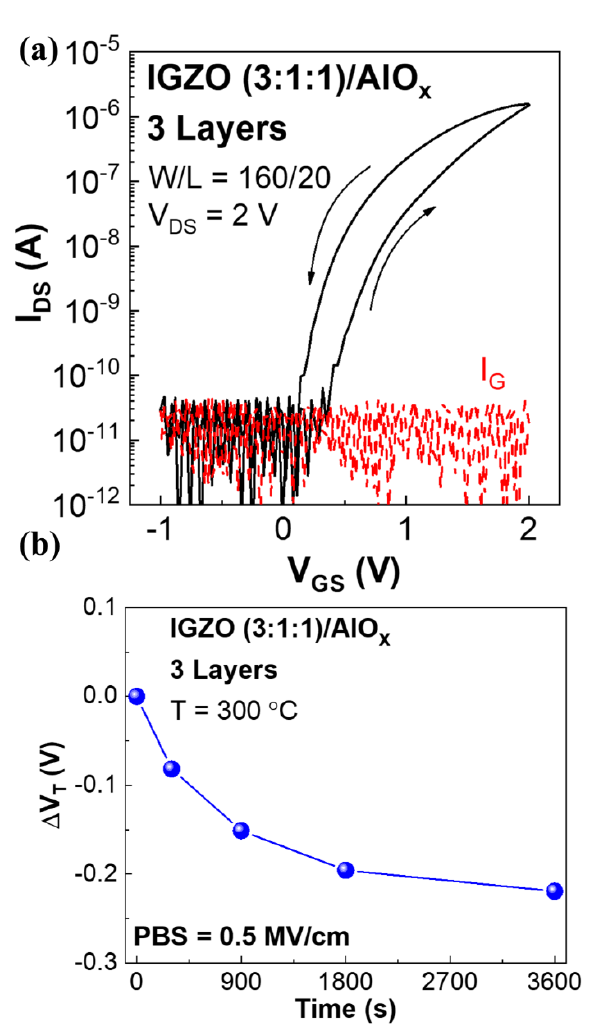
Figure 5. ( a ) Transfer characteristics of a fully solution-based passivated 3-layer IGZO 3:1:1/AlO x TFT; ( b ) threshold voltage variation (ΔV T ) under positive gate bias stress (PBS) (0.5 MV·cm −1 ) for 1 h in air environment.